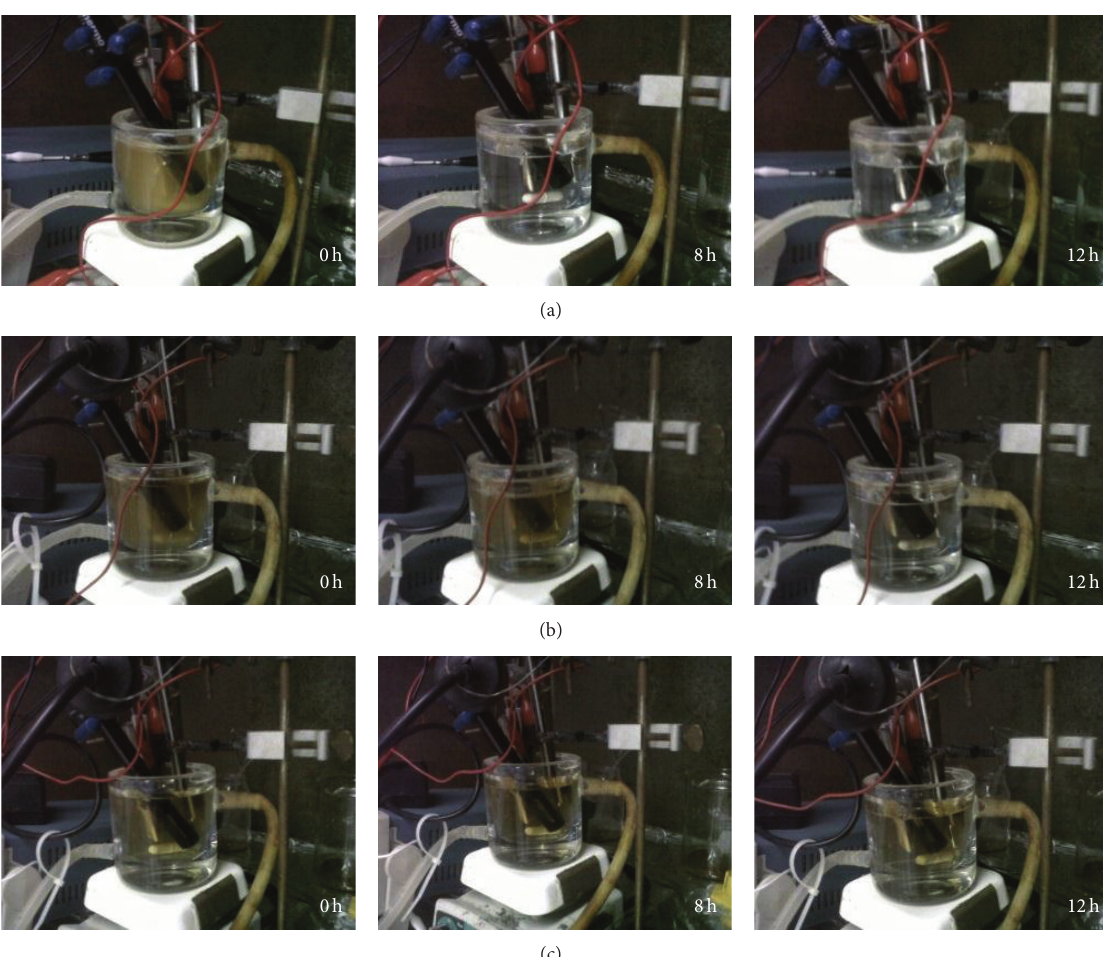
Figure 8: Images of electrolysis of spent caustic corresponding to the simple sample. (a) In the absence of UV light. (b) In the presence of UV light ( 𝜆 = 254 nm). (c) Photolysis, using Ti/BDD, applying 0.96 A ( 𝑗 = 0.32 Acm −2 ), under constant stirring, pH 1 (adjustment with H 2 SO 4 ) and 𝑡 𝑟 = 12 h.